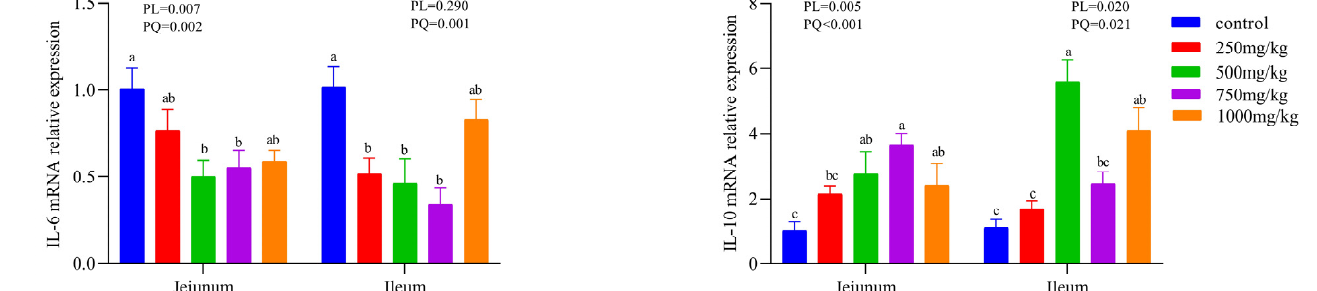
Figure 3. mRNA expression levels of inflammatory cytokines in the jejunum and ileum of laying hens ( n = 6). a–c Means with different superscripts within a column differ significantly ( p < 0.05). TNF- α : Tumor necrosis factor-alpha; IL-1 β : interleukin-1 beta; IL-6: interleukin-6; IL-10: interleukin-10.